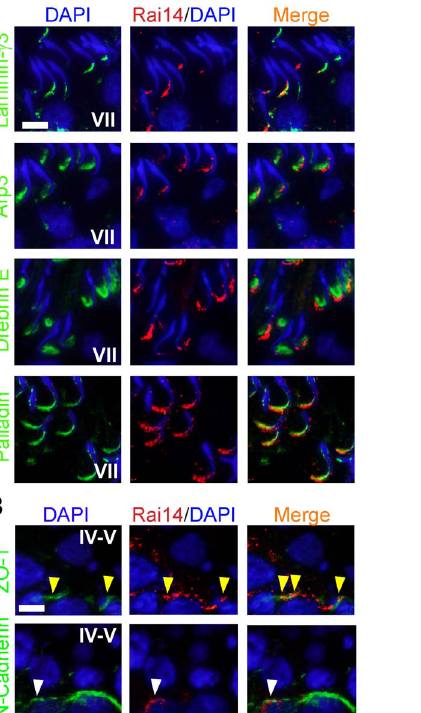
Figure 3. Rai14 is an apical and basal ES protein in the rat testis. Dual-labeled immunofluorescence analysis was used to assess co-localization of Rai14 (red) with constituent protein laminin- c 3 chain (green), actin regulatory protein Arp3 (green), actin binding protein drebrin E (green) and actin filament cross-linking protein palladin (green) at the apical ES in stage VII tubules when these proteins were all highly expressed. It was found that Rai14 indeed partially co-localized with each of these apical ES proteins (see ‘‘orange yellow’’ in merged images) as shown in ( A ). Rai14 (red) also partially co-localized with basal ES/TJ protein ZO-1 (see ‘‘yellow’’ arrowheads), and to a lesser extent with N-cadherin (see ‘‘white’’ arrowheads) in stage IV-V tubules when these proteins were highly expressed as shown in ( B ). Bar=10 m m in ( A ) or ( B ), which applies all other images in ( A ) and ( B ).